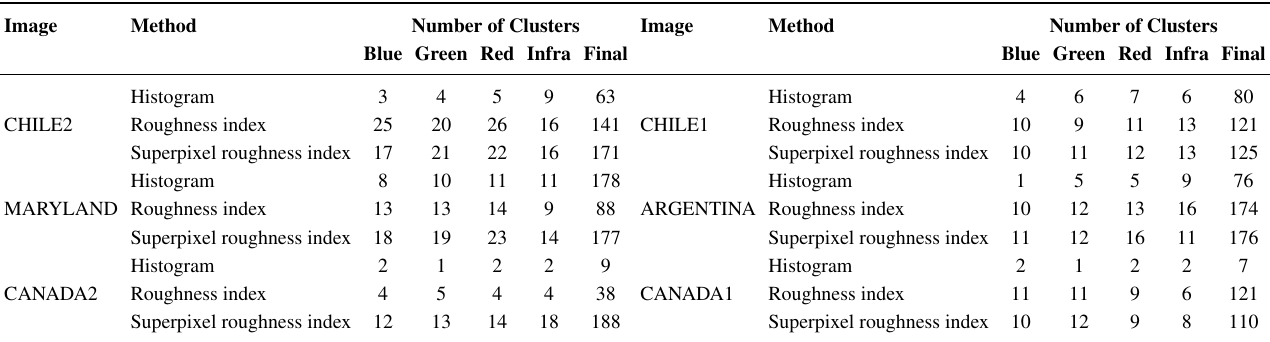
Table 1. Comparison of the numbers of spectral clusters yielded by the proposed method with the results of a histogram-based thresholding method and the results of the roughness index-based method, both per spectral band and the final, combined